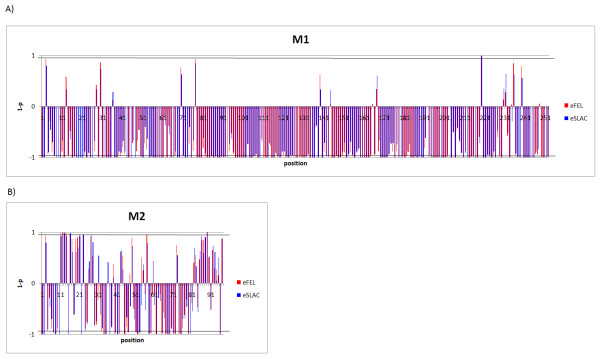
Selection profile by eFEL and eSLAC. Selection profiles of M1 (A) and M2 (B) are shown. The abscissa indicates the codon position. The ordinate indicates the (1-p) value for each position, and is above or below the horizontal line when dN/dS > 1 or dN/dS < 1, respectively. The horizontal lines represent 0.95, so that the positions where the bars cross the lines above and below indicate the positively and negatively selcected sites, respectively. The results of eSLAC and eFEL are shown.